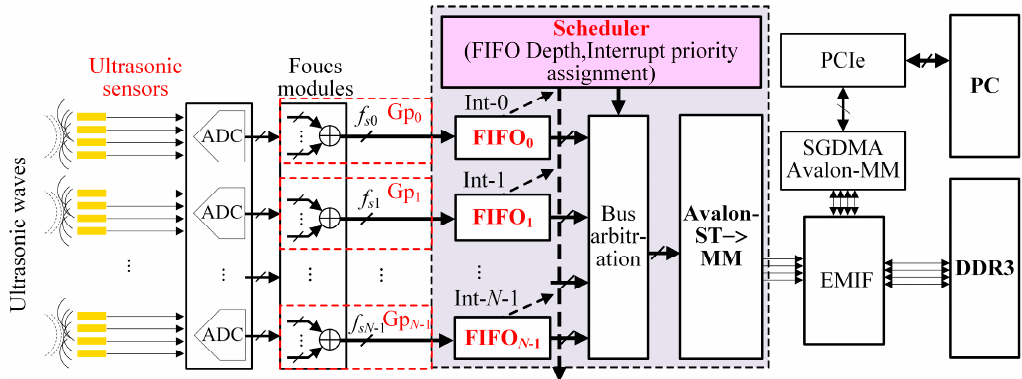
Figure 1. The diagram of the ultrasonic data transmission for the multi-sensor scanning.